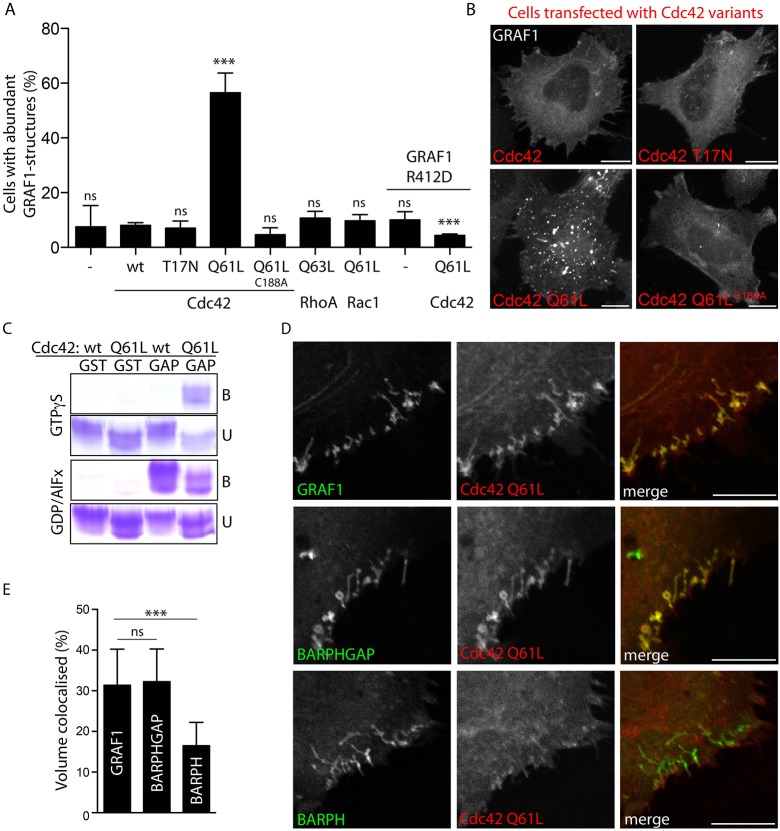
Interaction with transition state Cdc42 enforces membrane assembly of GRAF1. (A) Ratio of Flp-In T-REx HeLa cells showing a phenotype of abundant (≥15) GFP–GRAF1 or GFP–GRAF1-R412D structures in the absence (−) or presence of co-expressed CoralHue-tagged small GTPases and mutants thereof. For statistical analysis, cells from at least three independent experiments were included. The results were compared to the GRAF1 samples expressing wild-type Cdc42, or in the case of GRAF1-R412D cells, were related to the corresponding GRAF1 samples (mean±s.d.; Chi-square tests, n≥300 cells, α=0.05; ns, not significant; ***P<0.0001). (B) Maximum intensity projections of confocal stacks detecting GFP–GRAF1 in cells co-expressing the indicated CoralHue-tagged Cdc42 proteins. (C) Coomassie-stained SDS-PAGE gel from a pulldown experiment using purified GST (GST) or a GST-tagged GRAF1 GAP domain (GAP) as bait, and purified Cdc42 or Cdc42-Q61L loaded with GTPγS or GDP in the presence of AlFx (GDP/AlFx) as prey. The bound (B) and unbound GTPases (U) were detected. (D) Maximum intensity projections of confocal stacks detecting GFP–GRAF1 or indicated truncates (the BAR-PH-GAP and BAR-PH domains) and CoralHue–Cdc42-Q61L in transfected HeLa cells. (E) Percentage volume of GFP–GRAF1 proteins colocalised with CoralHue–Cdc42-Q61L, as visualised in D. Three independent experiments were analysed (mean±s.d.; Kruskal-Wallis test, Dunn's post test, n=15 cells, α=0.05; ns, not significant; ***P>0.0001). Scale bars: 10 μm.